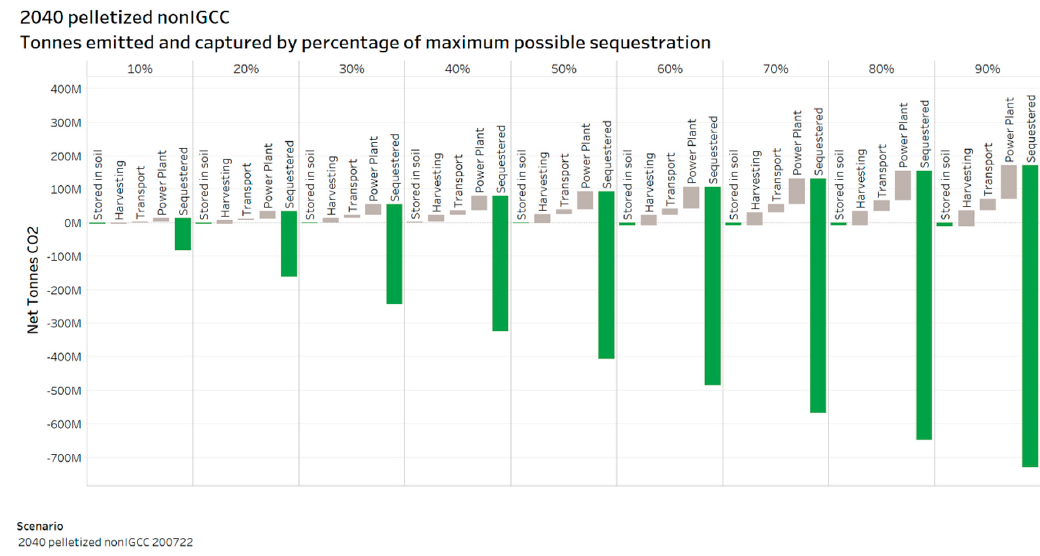
Figure 13. Net CO 2 flux by supply chain stage, example for 2040 pulverized combustion pelletized biomass scenario. CO 2 losses at stages of harvest (including biomass production), transport, and power generation are show in grey; total sequestered CO 2 is shown in green; CO 2 sequestration net of supply chain emissions is shown as the quantity less than zero. Interactive visualization of all scenarios is available at https://doi.org/10.11578/1647453.